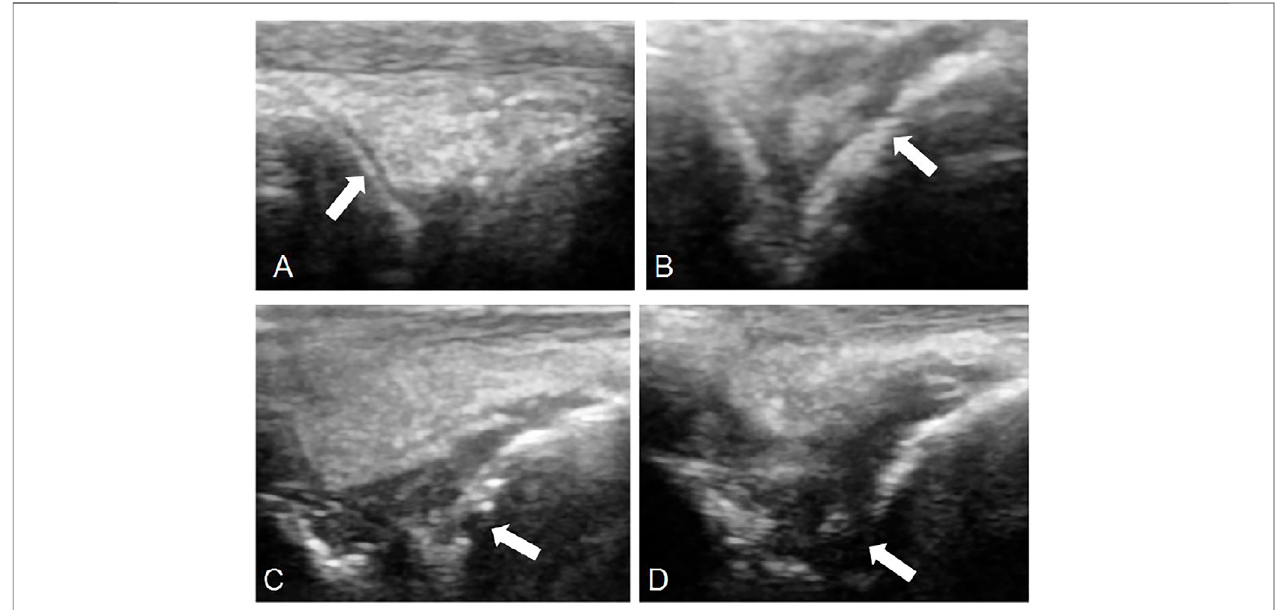
FIGURE7| Observation ofbone destruction byultrasound.0: Nobone damage onthe surface ofbone (TP-SLN group, (A) ).One point: The surfaceofbone isnot smooth, but there is no bone destruction (TP group, (B) ). Two points: Slight bone defect on bone surface (DMSO group, (C) ). Three points: extensive bone destruction on bone surface (control group, (D) ).